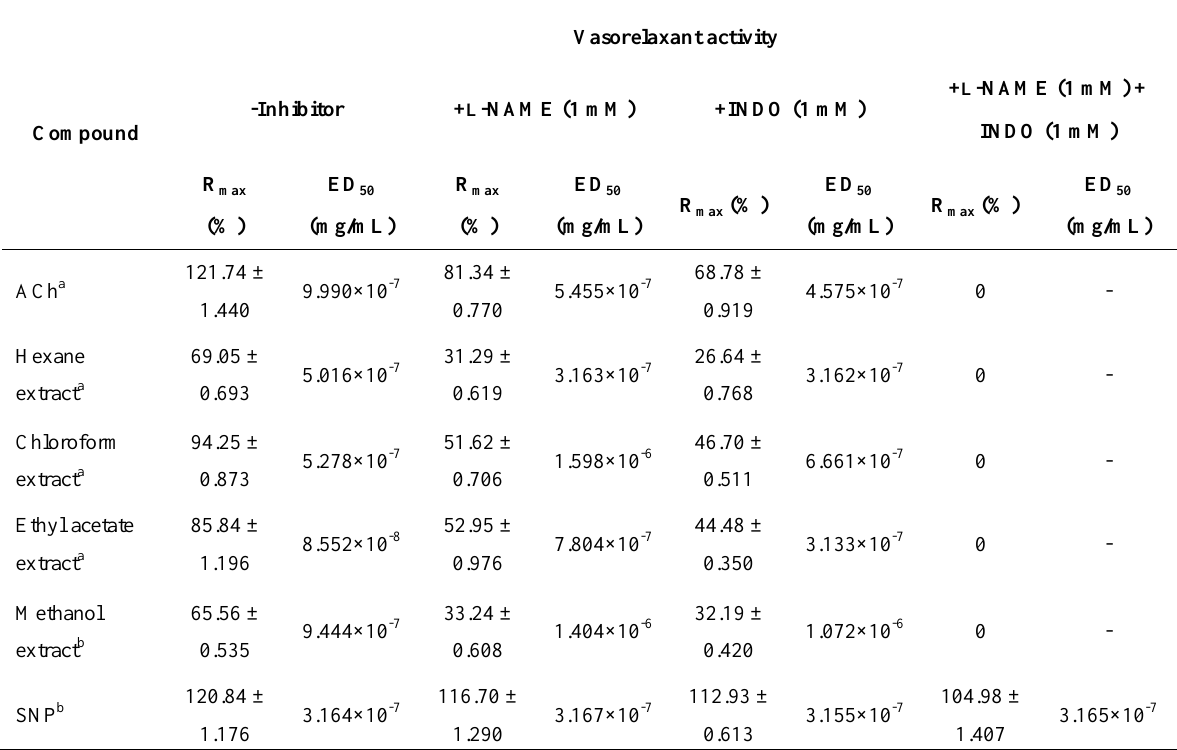
Table 4. Effect of inhibitors on vasorelaxant activity of Spilanthes acmella Murr. extracts.